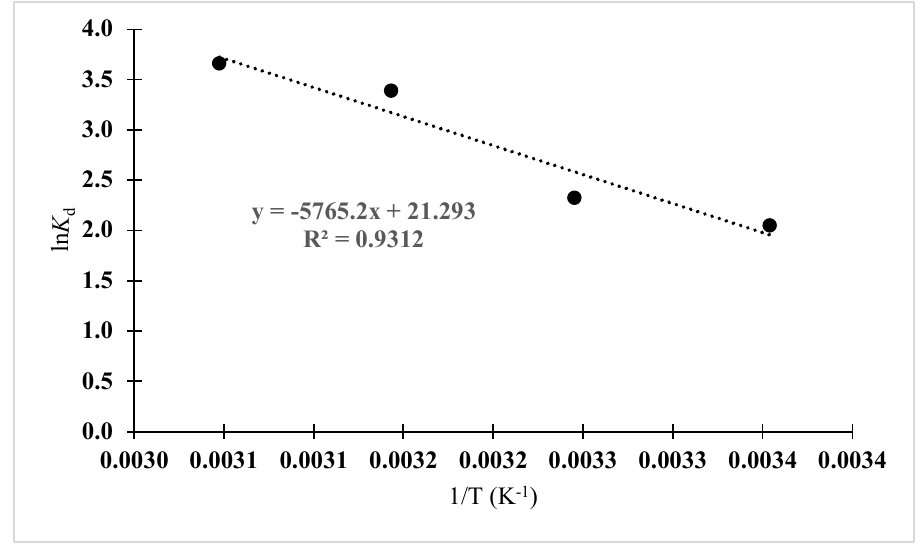
Figure 9. Van’t Hoff plot for MB dye removal by BWAC. Table 9. Thermodynamic parameters for the adsorption for MB dye by BWAC .